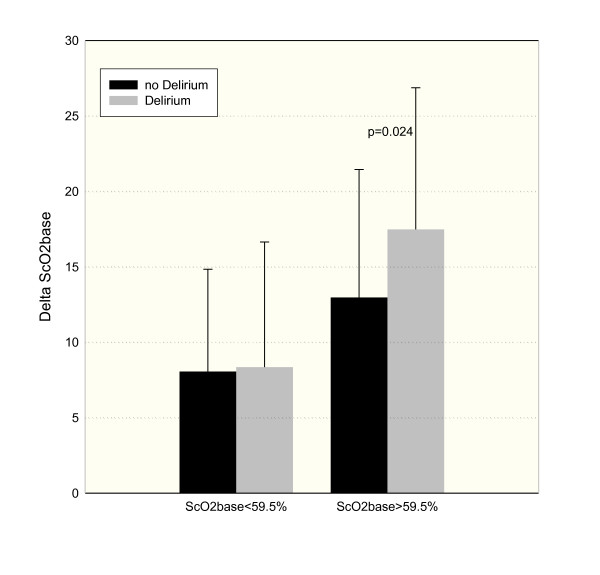
Intraoperative changes in ScO2 in patients with or without delirium classified by normal or low preoperative ScO2. Delta ScO2base, difference between preoperative regional cerebral oxygen saturation with oxygen supplementation and minimal intraoperative regional cerebral oxygen saturation; ScO2base, regional cerebral oxygen saturation with supplemental oxygen.